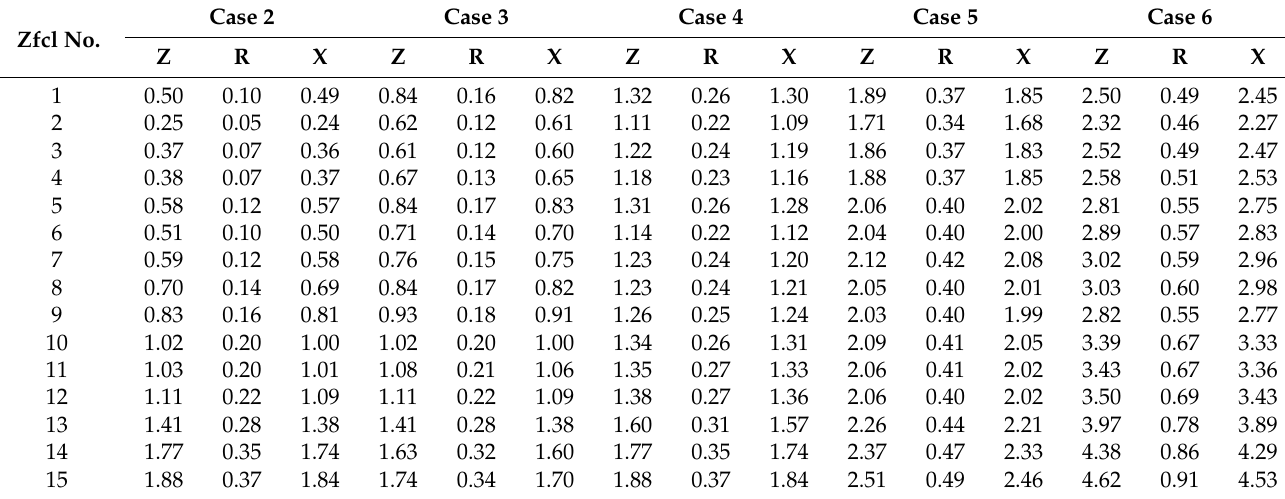
Table 2. Optimized Z fcl (ohms) parameters using the hybrid GWO